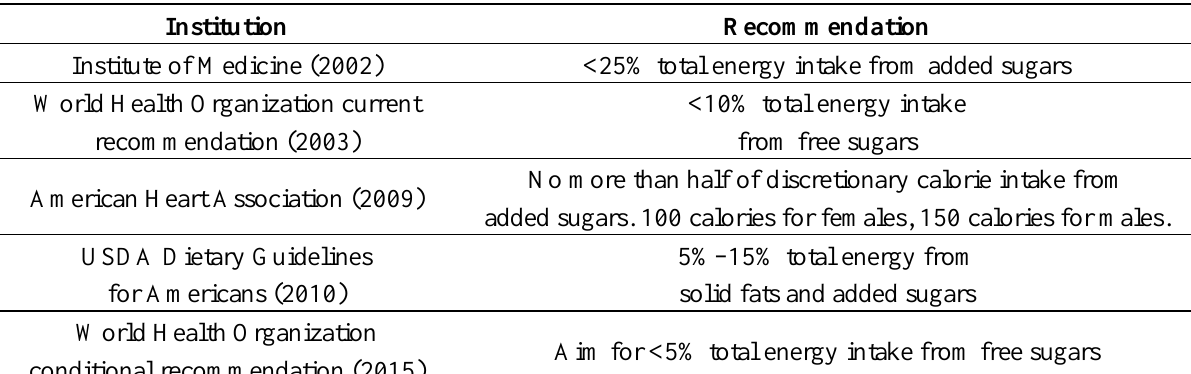
Table 1. Current and proposed recommendations for added sugar intake for Americans